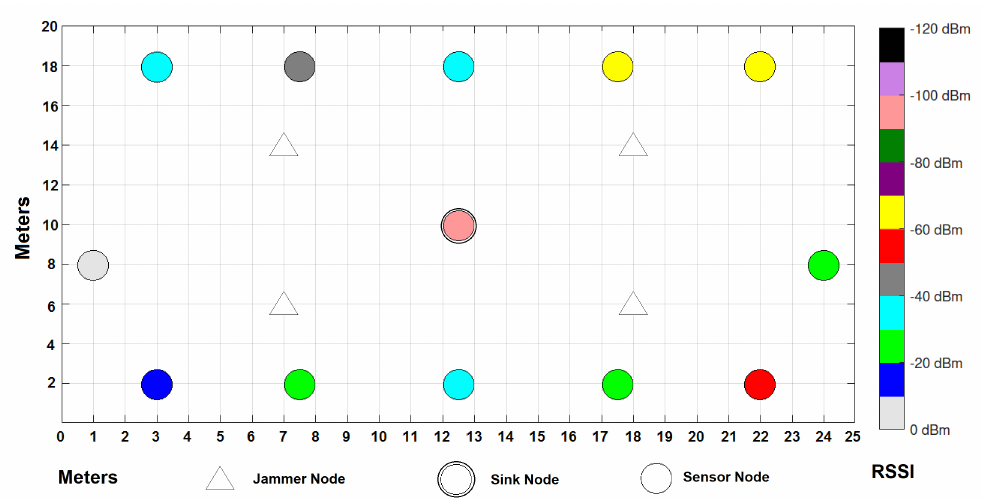
Figure 15. RSSI results per node under a collaborative